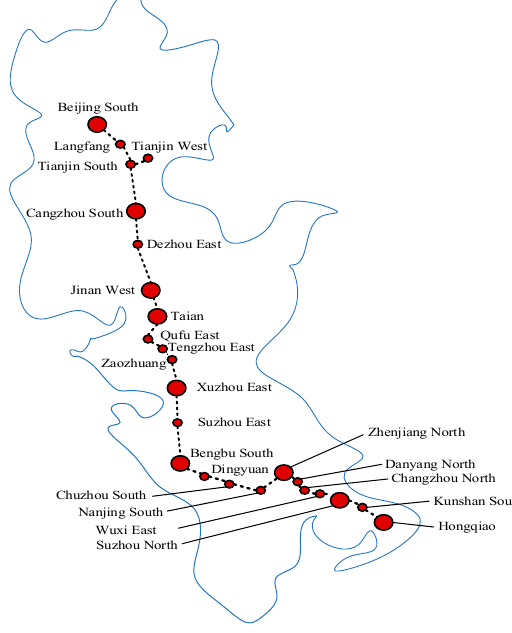
Figure 9. Map of Beijing-Shanghai high-speed railway corridor.